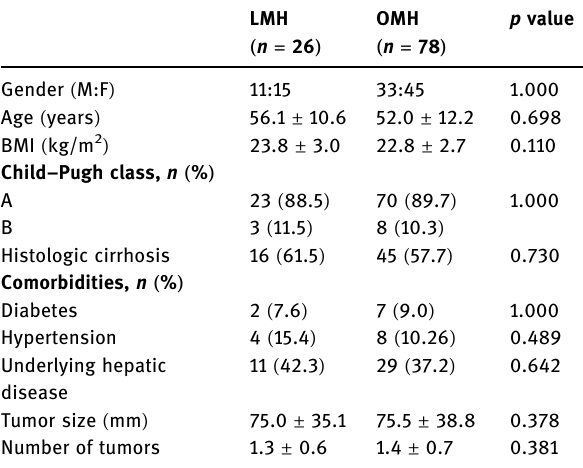
Table 1: Patients ’ characteristics and perioperative outcomes